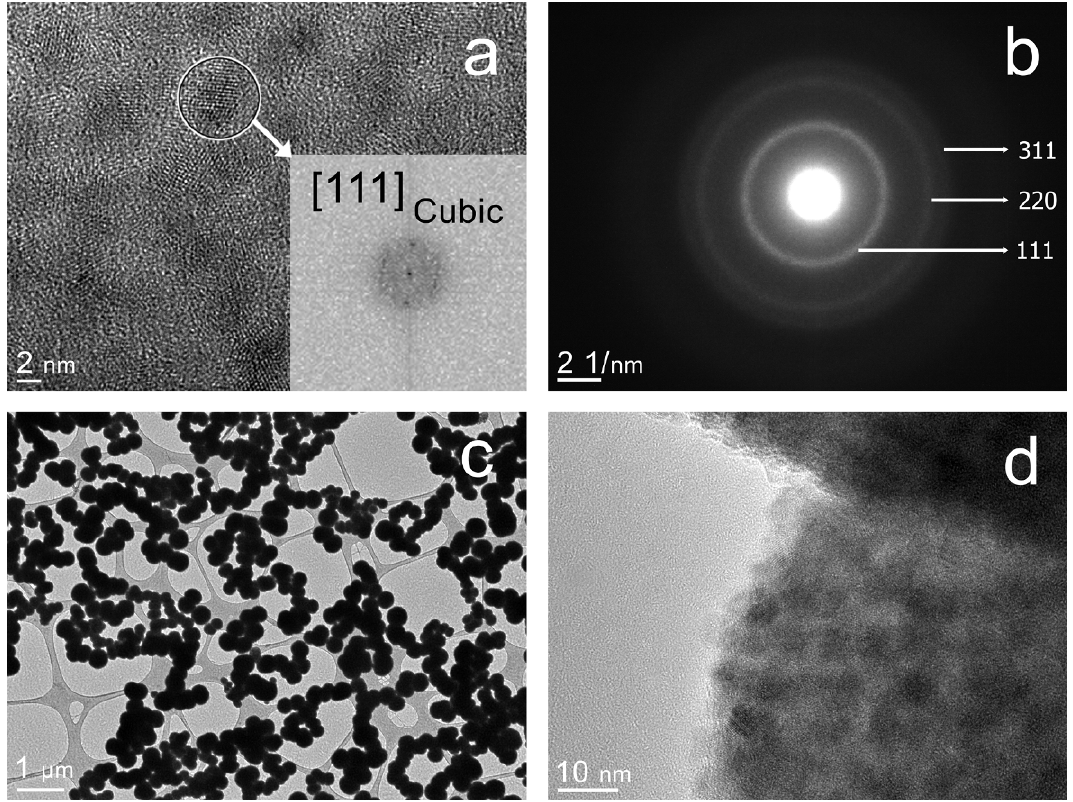
Figure 2. (a) HRTEM image and (b) SAED pattern of ZnS QDs synthesized at 60°C for 3 min. Inset in (a) shows FFT of the area indicated with circle; (c) TEM image of ZnS agglomerated QDs synthesized at 120°C for 60 min; (d) HRTEM image of one of the agglomerated particles in